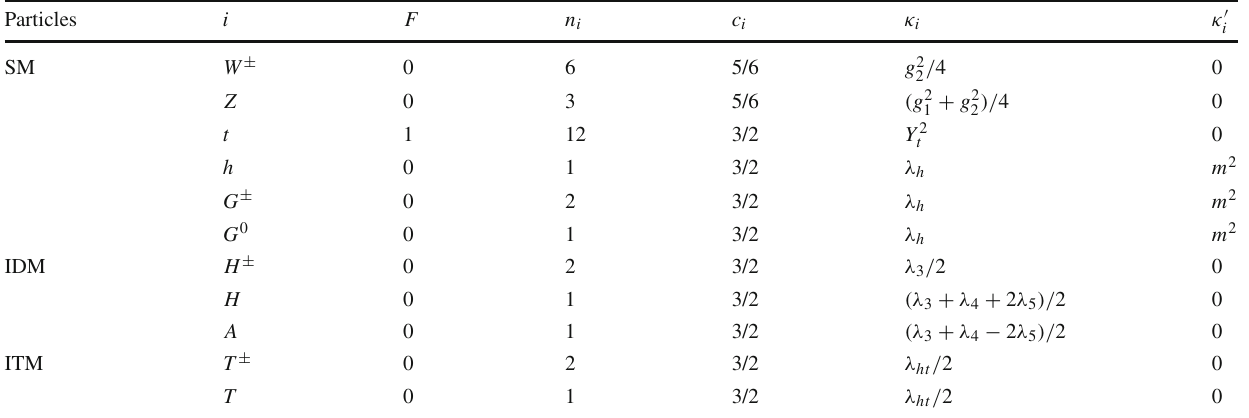
Table 1 Coefficients entering in the Coleman-Weinberg effective potential, cf. Eq. (6.9)